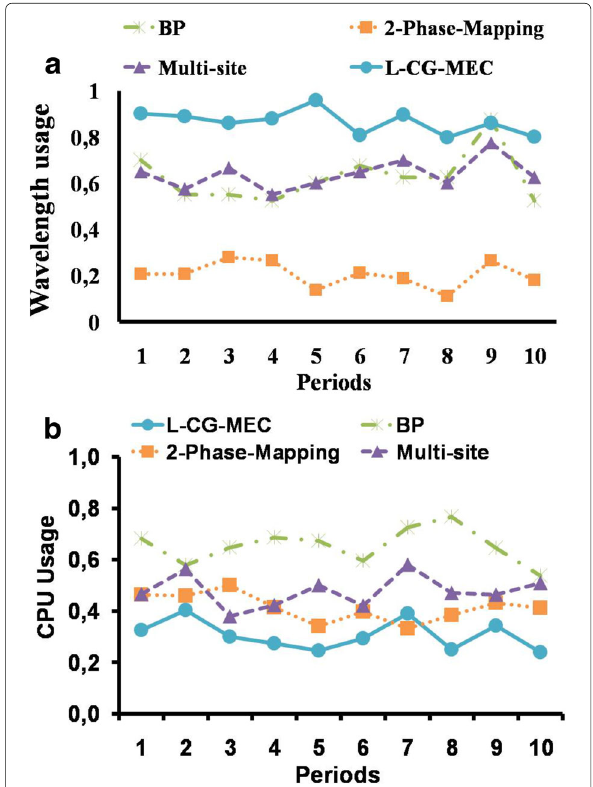
Fig. 5 MEC-DCs Resource utilization for L-CG-MEC vs. Benchmark approaches. a Wavelength bandwidth usage. b CPU usage